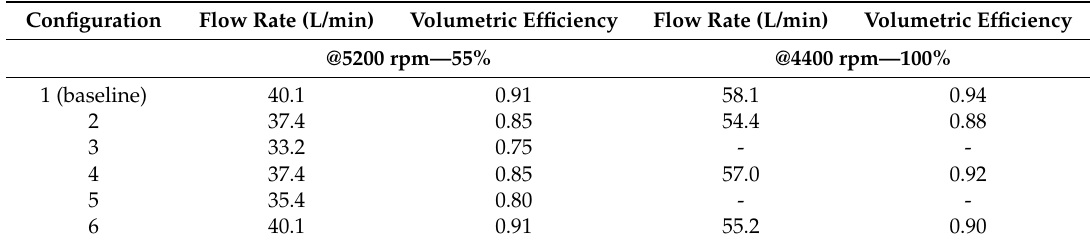
Table 2. Simulated flow rate and volumetric efficiency at 5200—partial displacement (55%) and at 4400 rpm—full displacement (100%).